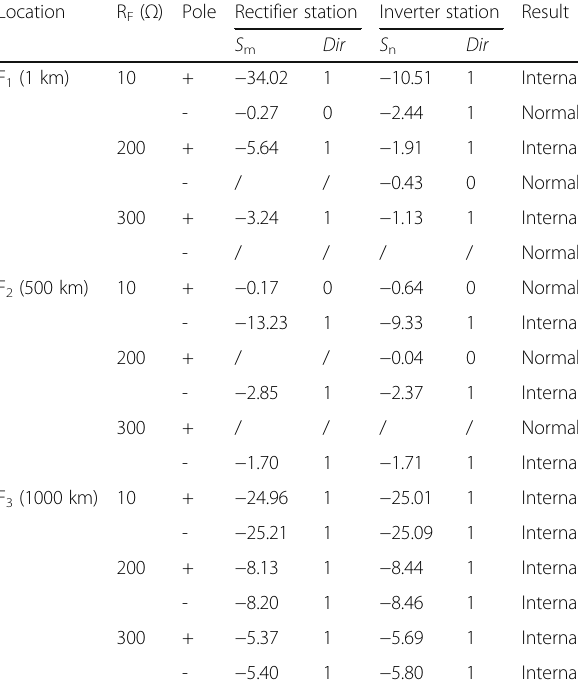
Table 6 Simulation results for internal DC line faults Location